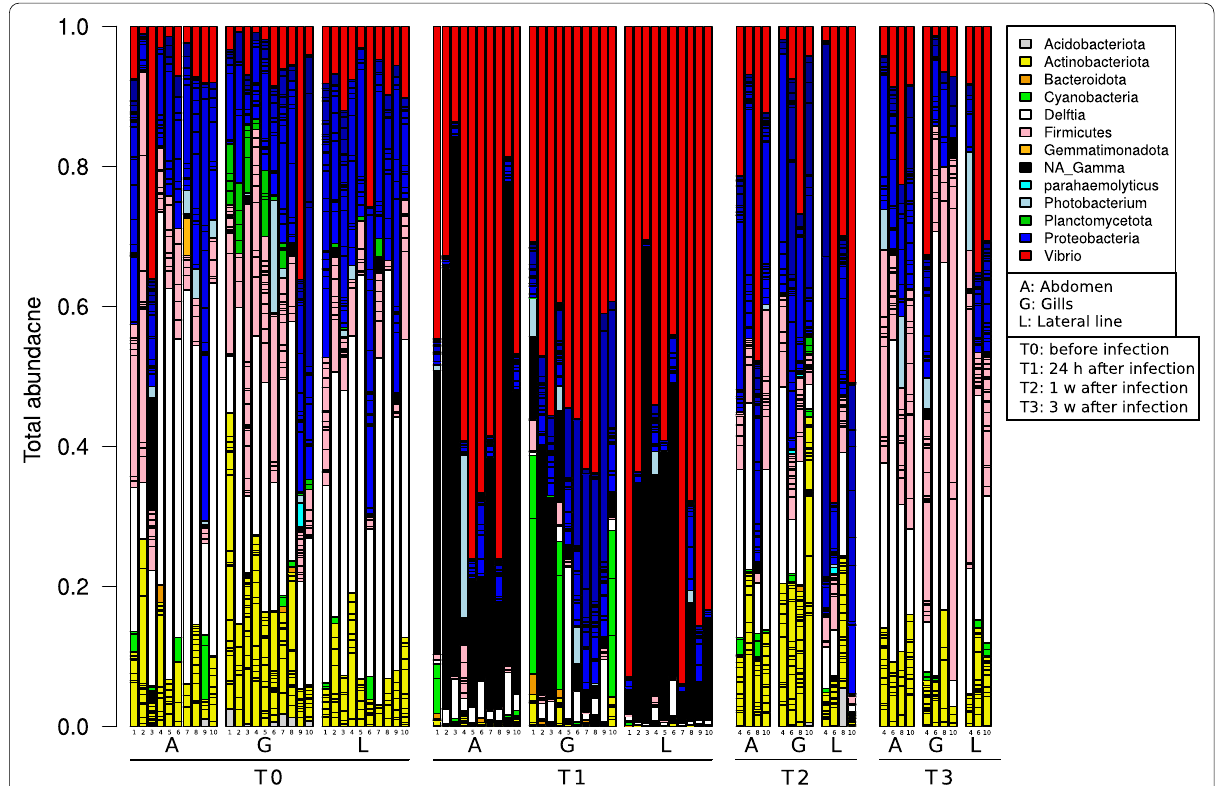
Fig. 4 Bar graph illustrating relative abundances of different bacterial phyla (different colors). Each bar represents one (tagged) fish at different grown in the non‑UV water tank at time points (T 0 before infection, T 1 24 h, T 2 one week, T 3 three weeks post infection), body sites (Abdomen (A); Gills (G); Lateral line (L)) for non‑UV treatment, during V. harveyi infection in summer,